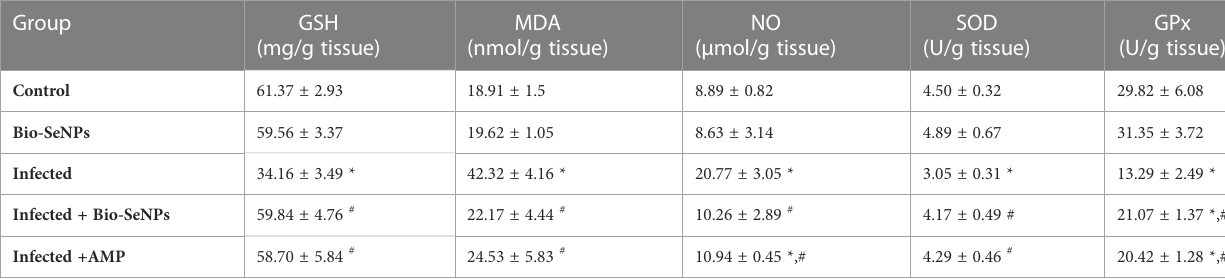
* indicates a signi fi cance against the control group with p< 0.001 and # indicates a signi fi cance against the infected group with p<